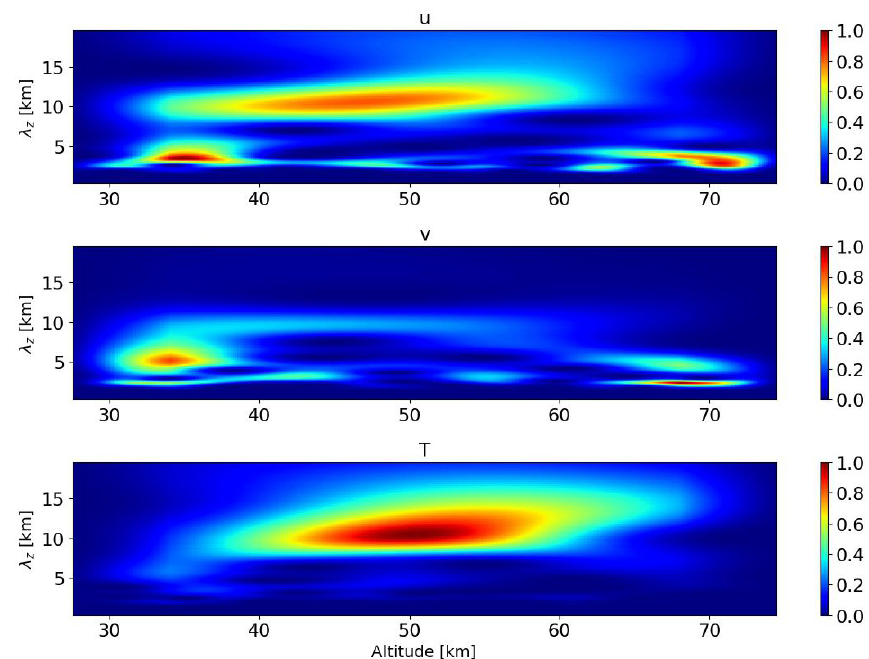
Figure 5. Wavelet transform of zonal and meridional wind and temperature fluctuations at 02:07UT on 10 January